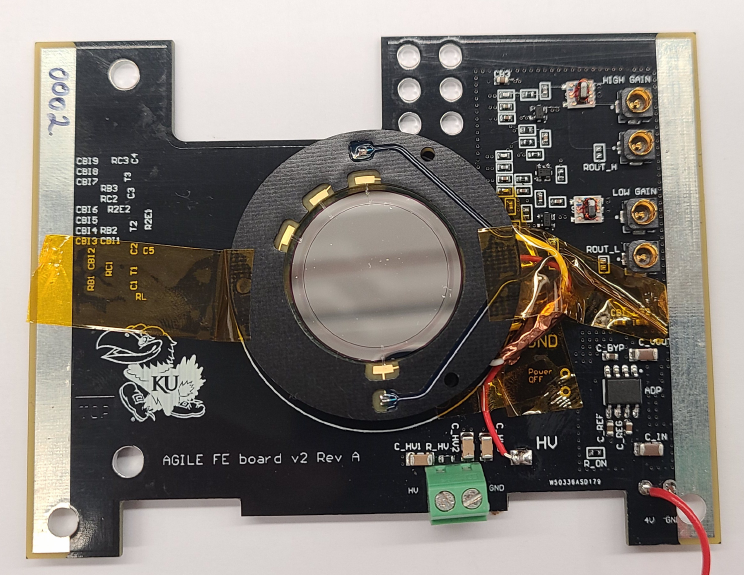
Figure 2. Photograph of the Micron Semiconductor Ltd MSD020 Si sensor connected to the read-out electronics board (9 cm by 8